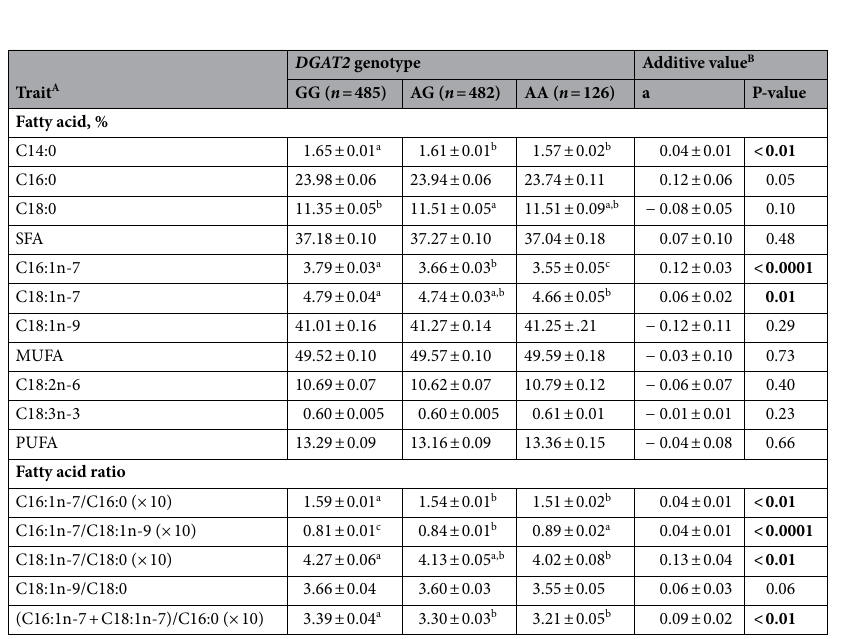
Table 2. Least square means and additive values (± standard error) for fatty acids content and fatty acid ratios in the gluteus medius muscle by DGAT2 genotype. A SFA: saturated fatty acids (C14:0 + C16:0 + C18:0 + C20:0); MUFA: monounsaturated fatty acids (C16:1n-7 + C18:1n-9 + C18:1n-7 + C20:1n-9); and PUFA: polyunsaturated fatty acids (C18:2n-6 + C18:3n-3 + C20:2n-6 + C20:4n-6). B Additive allele substitution of G for A. a,b,c Within trait, means with different superscripts differ significantly (P < 0.05). Bold font indicates statistical